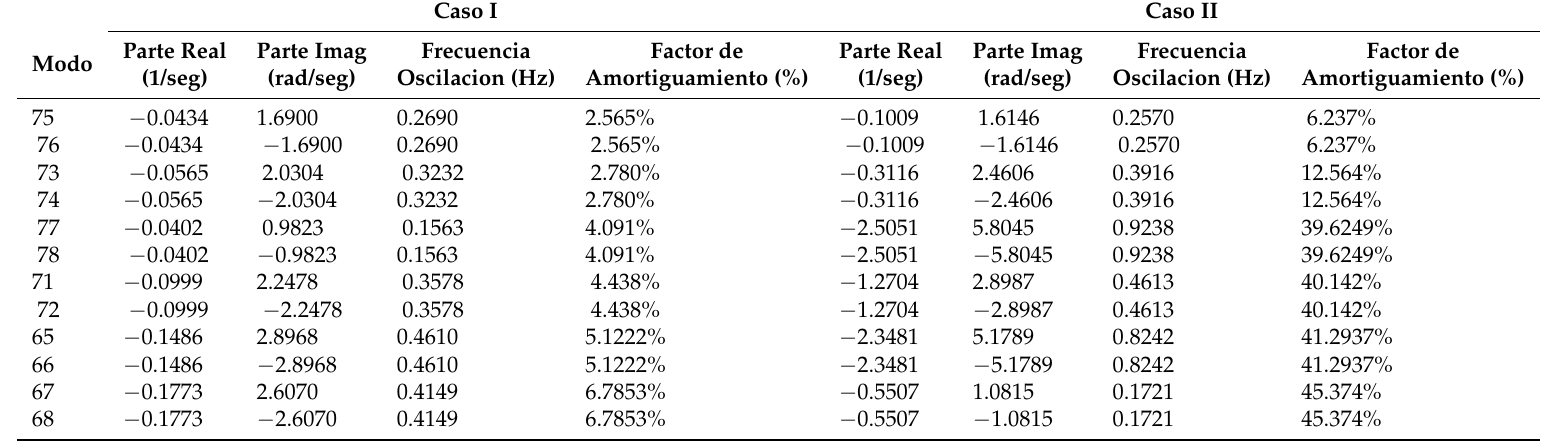
Table 11. Valores propios del sistema